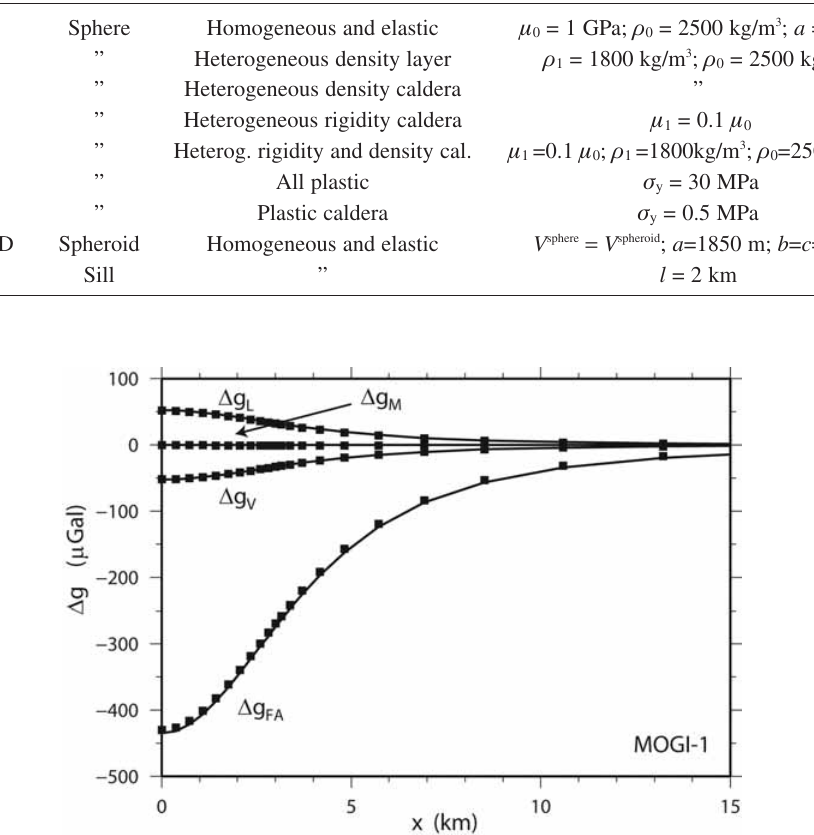
Fig. 6. Contributions and medium gravity change due to an inflating spherical pressure source in a homoge- neous and elastic half-space. Comparison between analytical solutions (solid line) and numerical (squares). The contribution due to the inflation of a massless sphere ∆ g M = ∆ g L + ∆ g V is